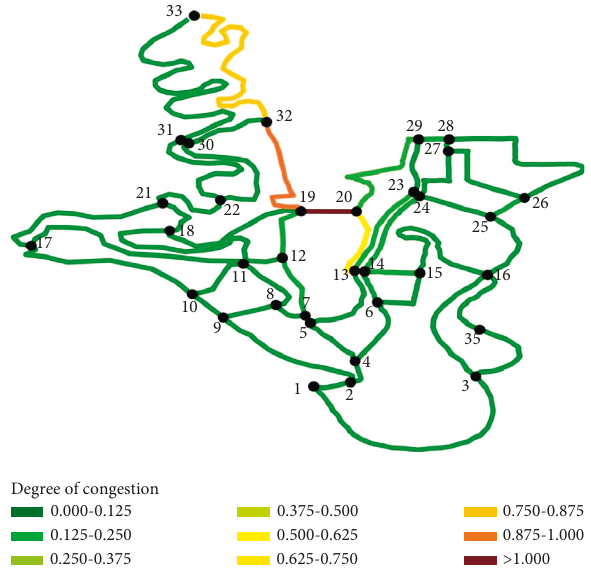
Figure 21: The maximum congestion of the road network for the scenario of ingress without VMS information releasing.